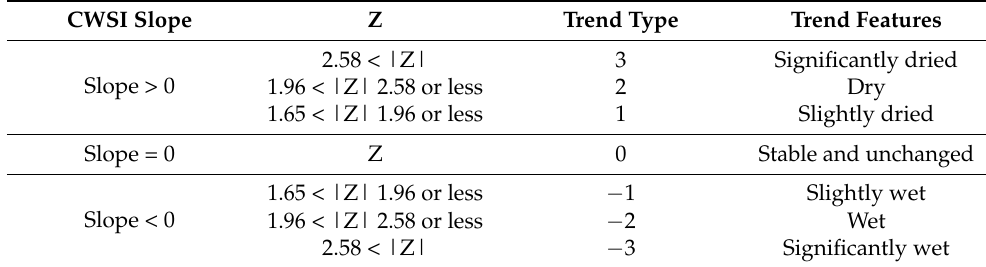
Figure 8. The trend of drought based on CWSI in 2001–2020. Table 2. Category of significant variation of drought trend.